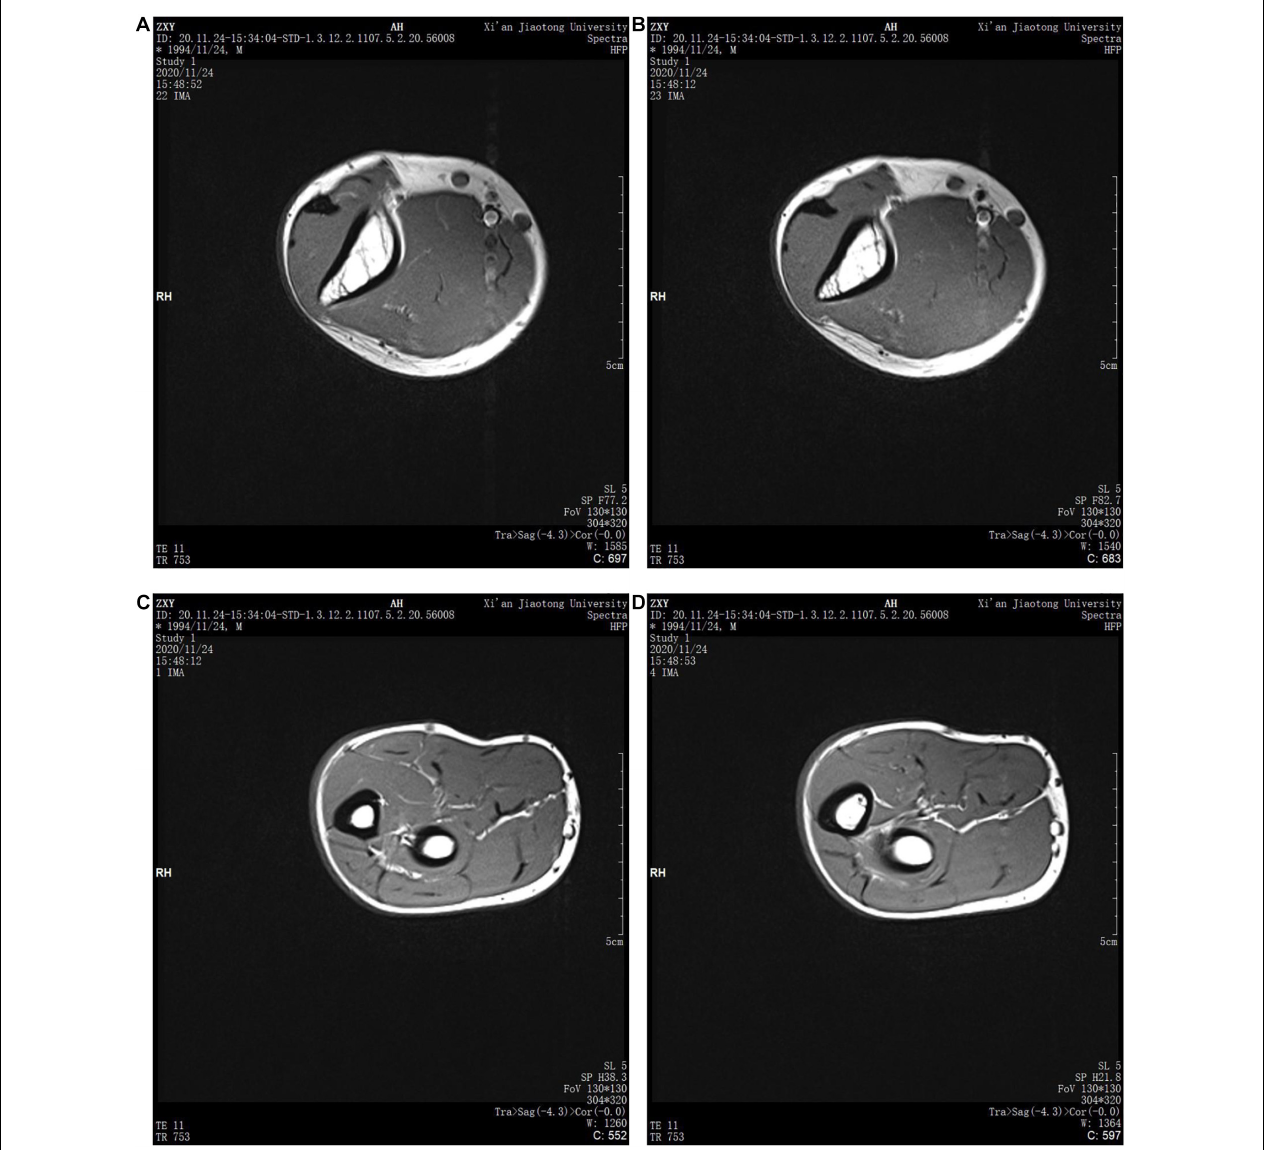
FIGURE 4 | MRI images of human upper limbs: (A) upper arm scan Figure 1 , (B) upper arm scan Figure 2 , (C) forearm scan Figure 1 , and (D) forearm scan Figure 2 .